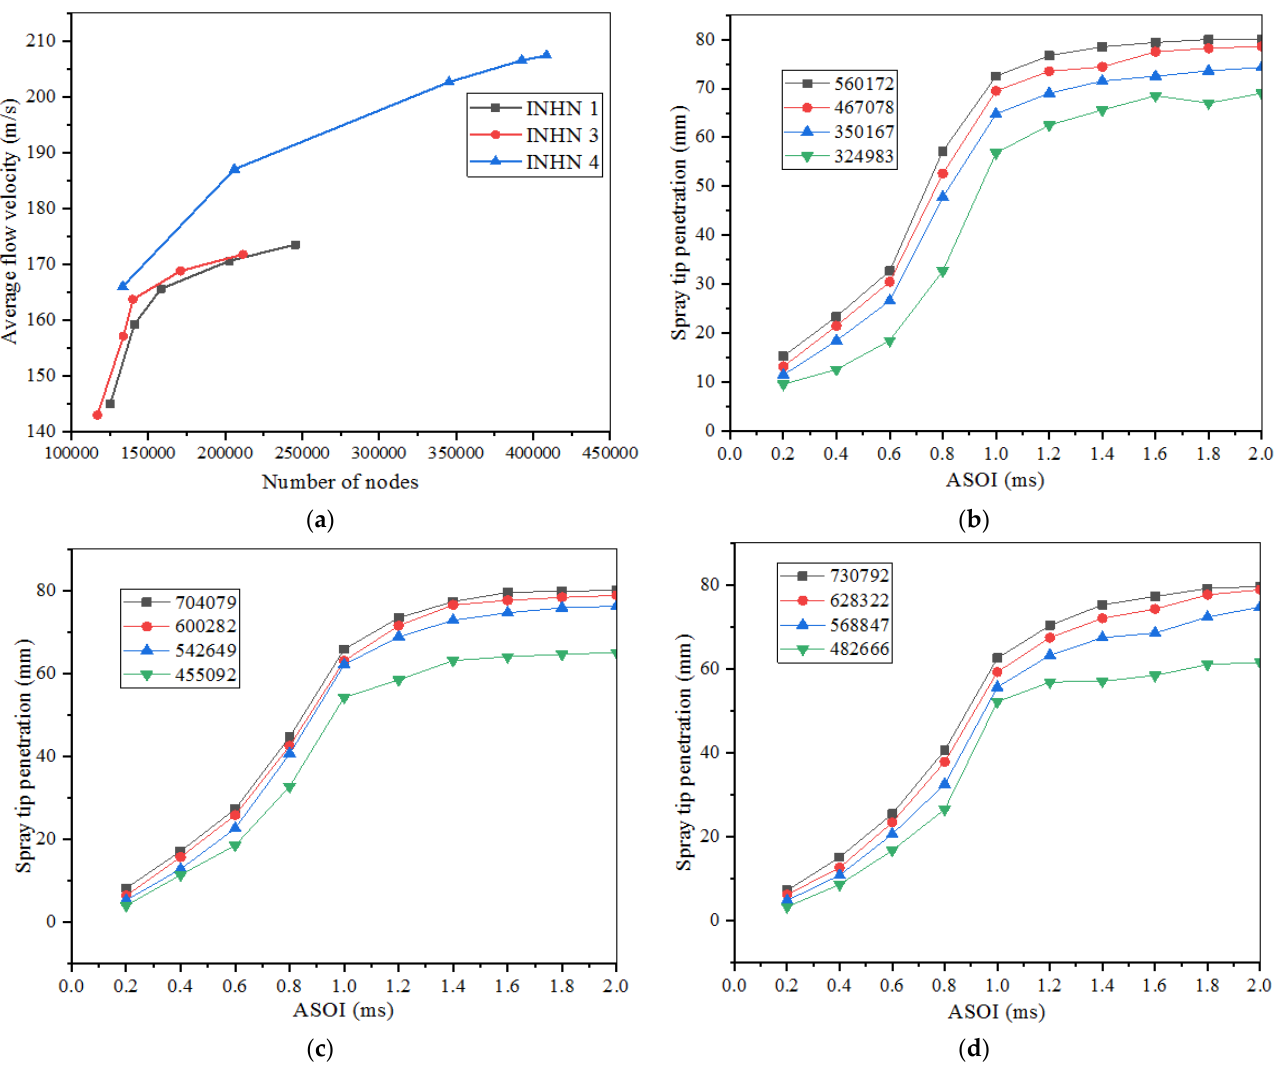
Figure 4. Spray simulation grid independence test: ( a ) nozzle models, ( b ) INHN-1, ( c ) INHN-3, and ( d ) INHN-4.